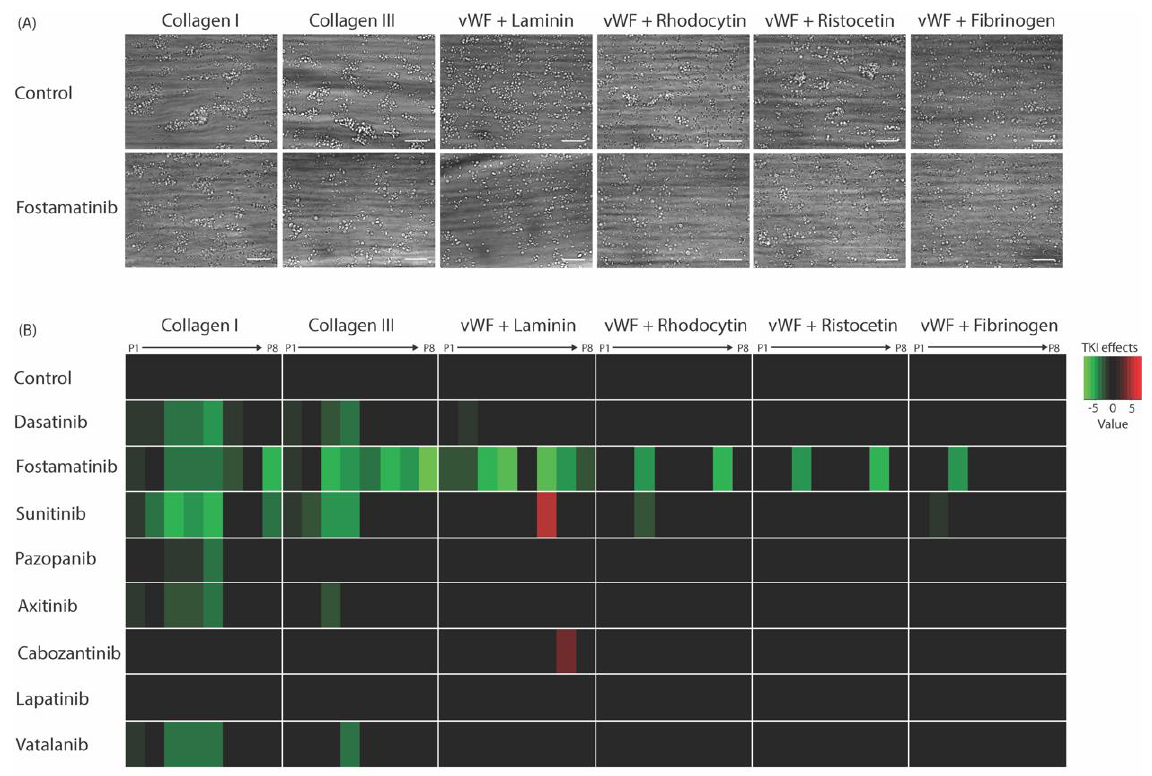
Figure 3. Effects of eight TKIs on whole-blood thrombus formation under flow on different thrombogenic surfaces. Blood samples were pre-incubated with the vehicle or TKI for 10 min. Samples were then recalcified in the presence of PPACK and perfused for 3.5 min at a wall shear rate of 1000 s − 1 over six different coated surfaces. After perfusion, the formed thrombi were stained with AF568-annexin A5, FITC- α -fibrinogen, and AF647- α -CD62P to detect PS exposure, integrin αIIbβ3 activation, and P-selectin expression, respectively. ( A ) Representative brightfield images of control or fostamatinib-treated blood after flow over collagen Type I, collagen Type III, vWF plus laminin, vWF plus rhodocytin, vWF plus ristocetin, or vWF plus fibrinogen. ( B ) Subtraction heatmap representing significantly altered effects of parameters P1 – P8 (normalized and analyzed as in Figure S2). Note: P1, morphological score of platelet adhesion and thrombus formation; P2, surface area coverage of the adhered platelets; P3, platelet aggregate contraction score; P4, platelet aggregate multilayer score; P5, coverage of multi-layered platelet aggregation; P6, α IIb β 3 activation; P7, P-selectin expression; and P8, PS exposure. The results from the vehicle control runs were set at 0. Effects were filtered for significant alterations ( p < 0.05) induced by TKIs.